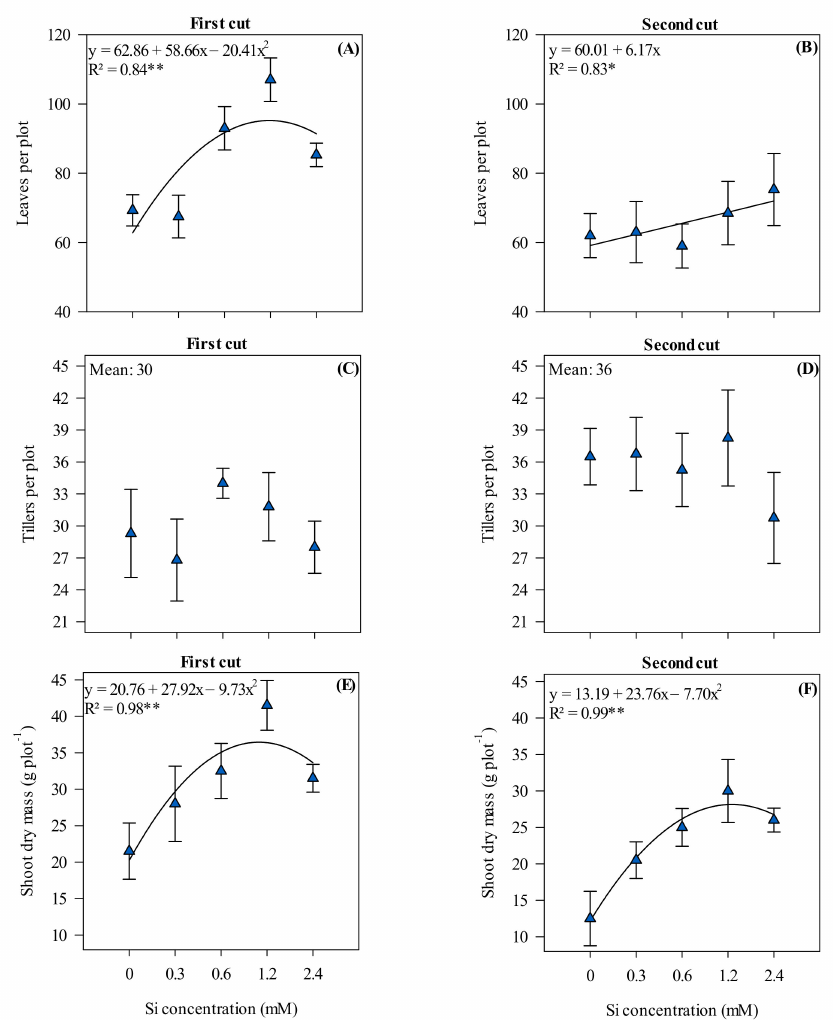
Figure 3. Number of leaves per plot in the first ( A ) and second cut ( B ), number of tillers per plot in the first ( C ) and second cut ( D ), and shoot dry mass in the first ( E ) and second cut ( F ) as a function of increasing Si concentrations in Xara é s palisadegrass. Error bars indicate the standard deviation of the mean ( n = 4). * and ** = significant at 5 and 1% probability by F test